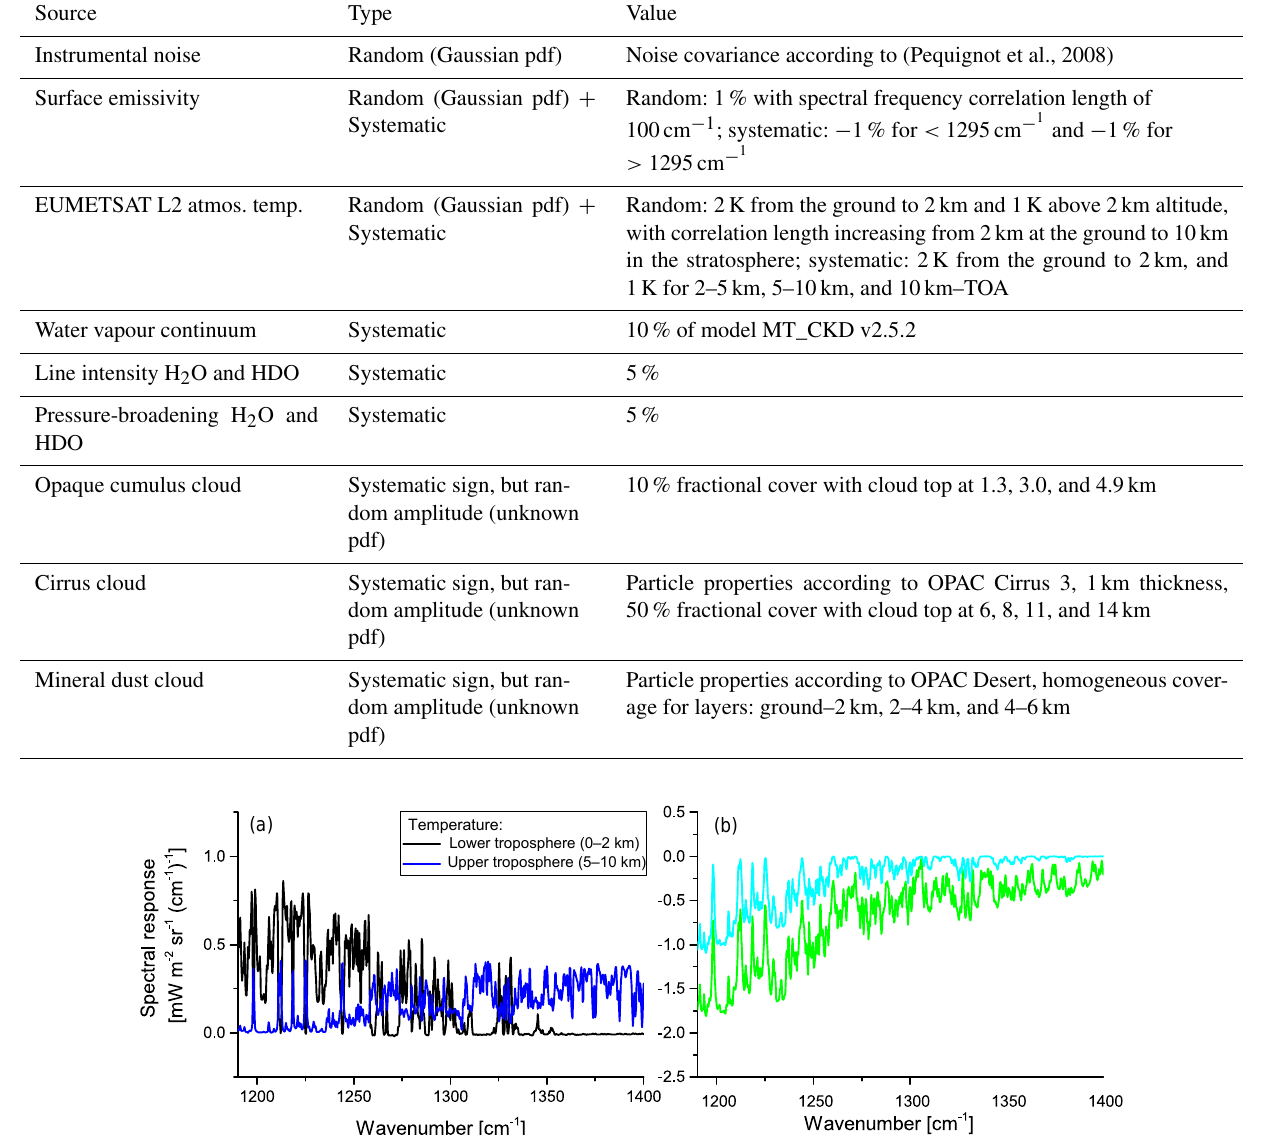
Figure 6. Spectral responses of uncertainty sources for a typical situation at Manus Island (same situation as for the kernel in Fig. 3). Panel (a) shows examples of the influence of uncertainties of temperatures (surface skin (cid:49)T = + 2K, lower tropospheric (cid:49)T = + 2K, and upper tropospheric (cid:49)T = + 1K). Panel (b) illustrates examples of the influence of clouds (dust layer (4–6km) and cirrus cloud (13–14km and 50% cloud fraction)) on the spectrum. Note the different y -axis scales, i.e. the positive response for positive temperature uncertainties and the negative response for unrecognized